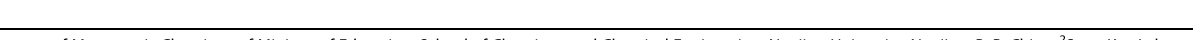
(Supplementary Table S4), surface energy, and surface